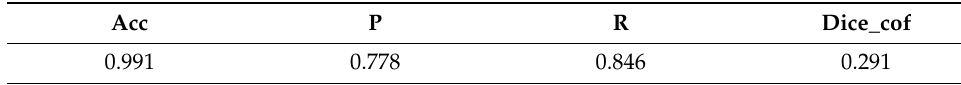
Table 2. The overall performance of the first model on LiTS dataset.